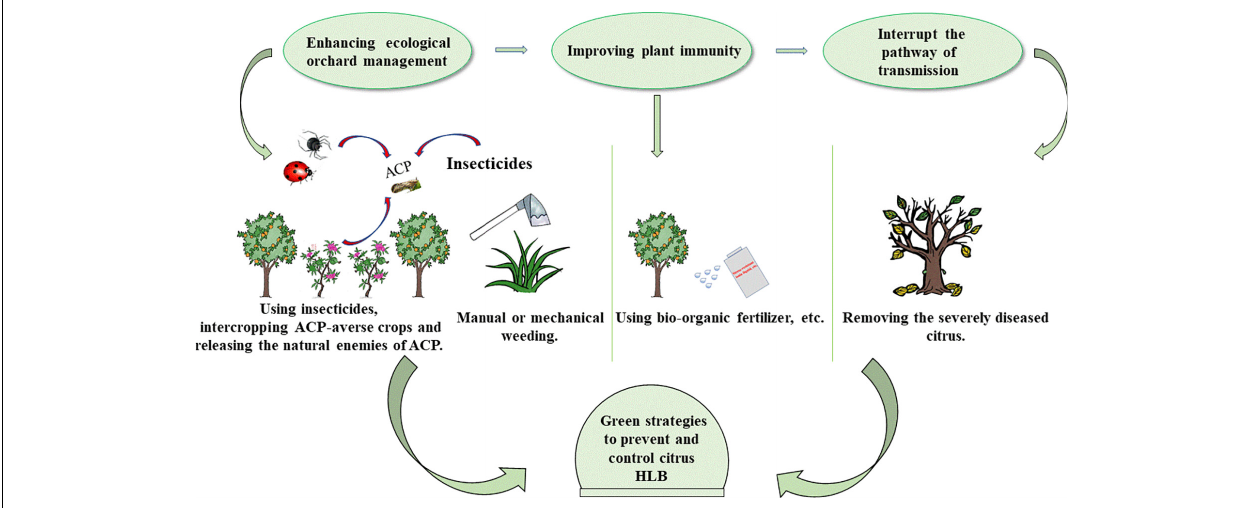
FIGURE 2 | Green strategies to prevent and control HLB. There are mainly three steps: first of all, enhancing the management of orchards by manual or mechanical weeding, intercropping ACP-averse crops, and releasing the natural enemies of ACP. Secondly, improving plant immunity. Using bio-organic fertilizer, spraying metabolic photosynthetic accelerators, and stress-resistant ionic liquids to enhance plant immunity. Finally, removing the severely diseased citrus to cutoff HLB from the source. HLB, Huanglongbing; ACP, Asian citrus psyllid.